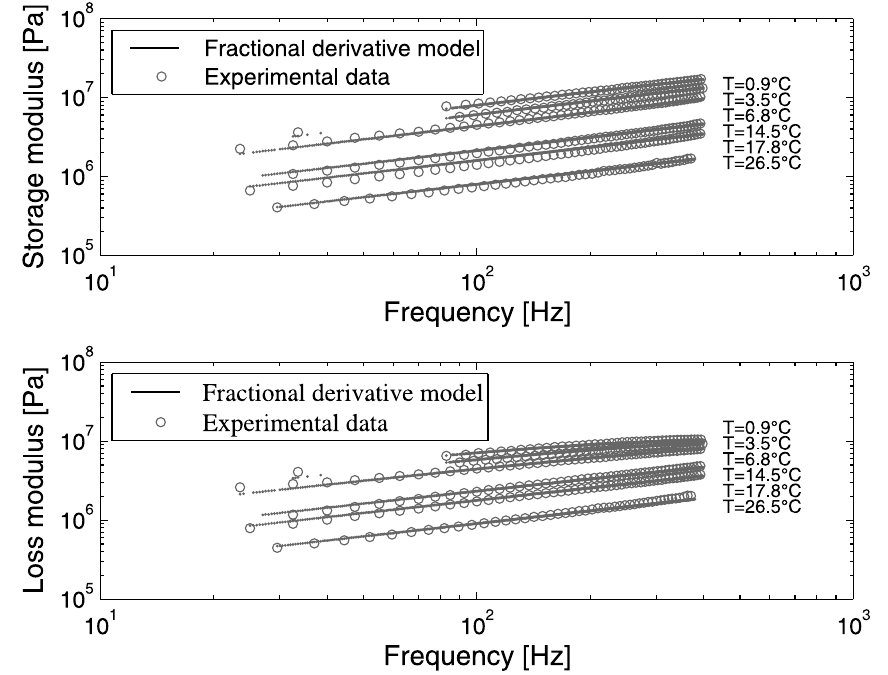
Fig. 9. Storage and loss modulus representation for the frequency-temperature fractional derivative model.